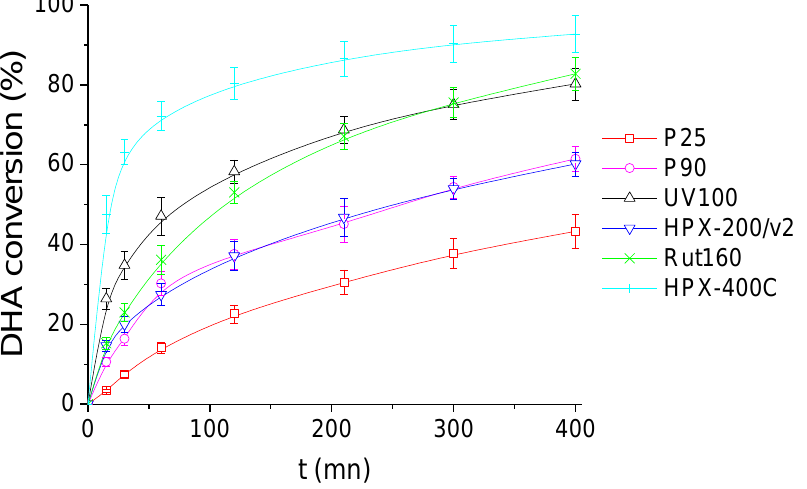
Figure 6. DHA conversion with the time course of the reaction in the presence of the six TiO 2 . Conditions: T = 90 ◦ C, P air = 1 atm, V water = 200 mL, (DHA) = 0.1 mol.L − 1 , (TiO 2 ) = 10 g.L − 1